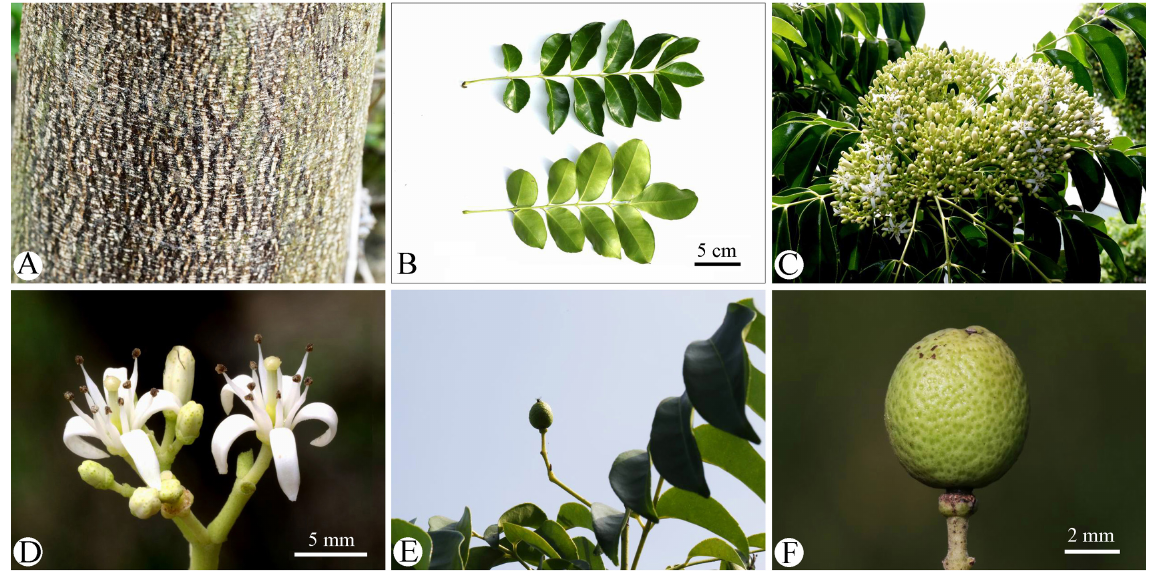
Fig. 4. Bergera crenulata (Turcz.) F.J.Mou comb. nov. A . Stem. B . Leaves. C . Inflorescence. D . Flowers. E–F . Fruit. Photos taken by Chuang His in Taiwan,